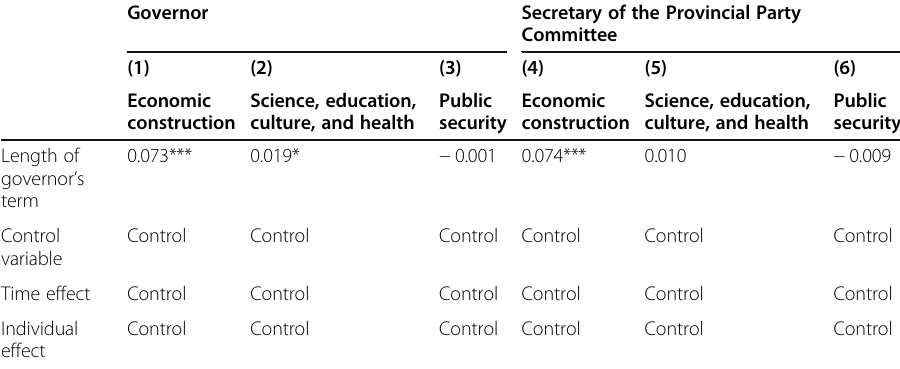
Table 8 Province-level data inspection